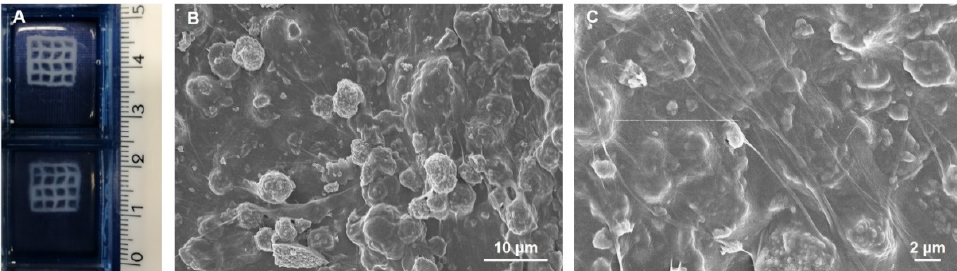
Figure 8. 3D mesh-like scaffolds of Coll/LPMS-HRP_PEG_TG ( A ) and FE-SEM images repre- senting their micro-structures at different magnifications ( B , C ). their micro-structures at different magnifications ( B , C